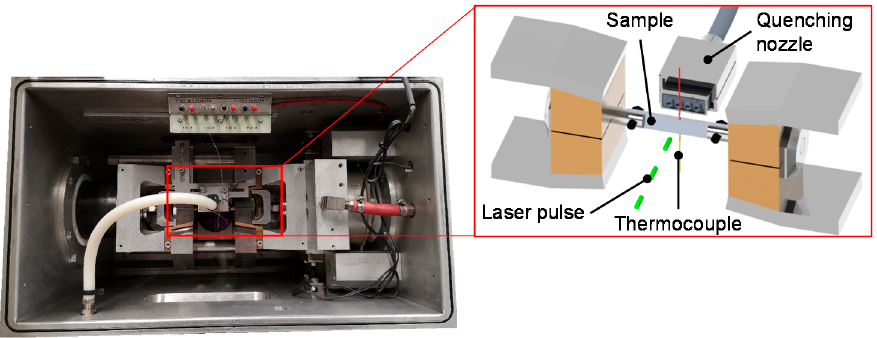
Figure 3. Experimental setup for the evaluation of the microstructural evolution during hot stamping employing a laser-ultrasound sensor.